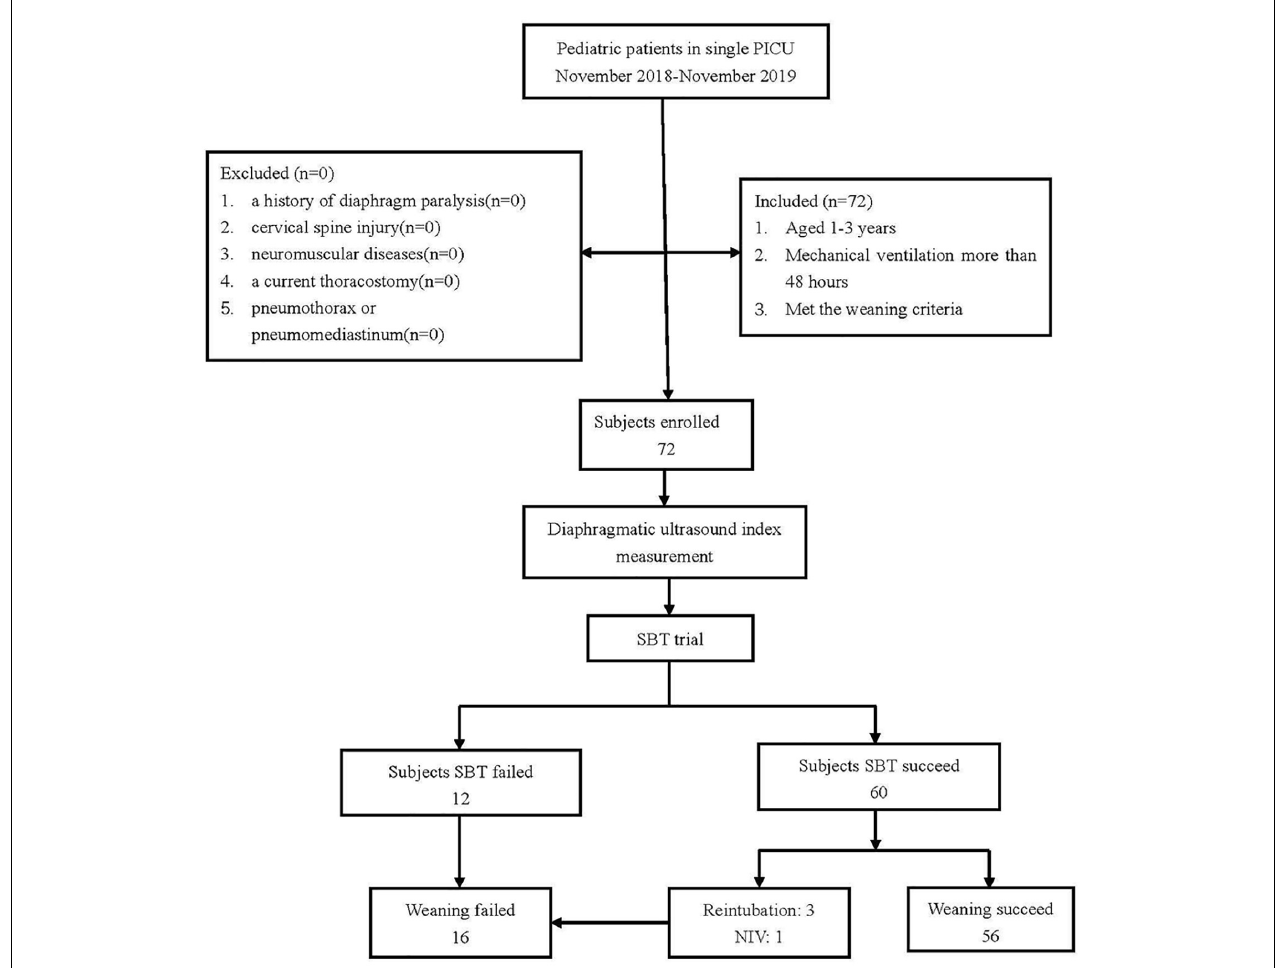
FIGURE 3 | A flow chart of subject enrollment. SBT, spontaneous breathing trial; NIV, non-invasive